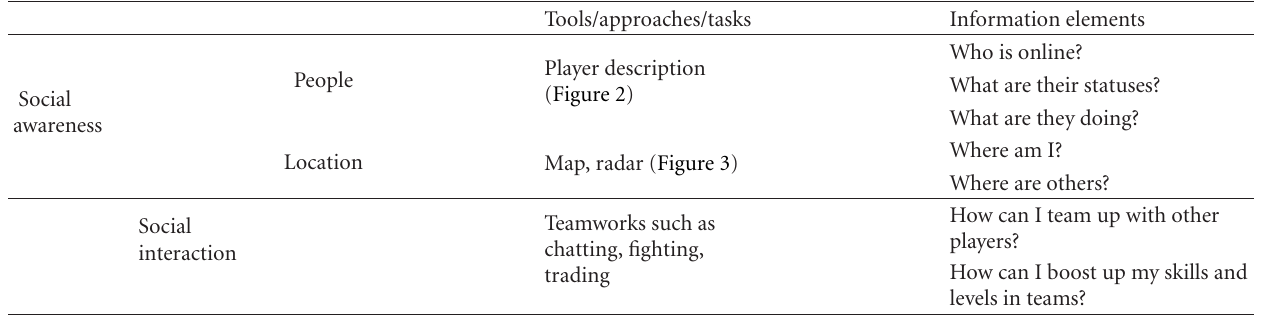
Table 1: A brief summery of awareness and interaction design elements in LastWorld